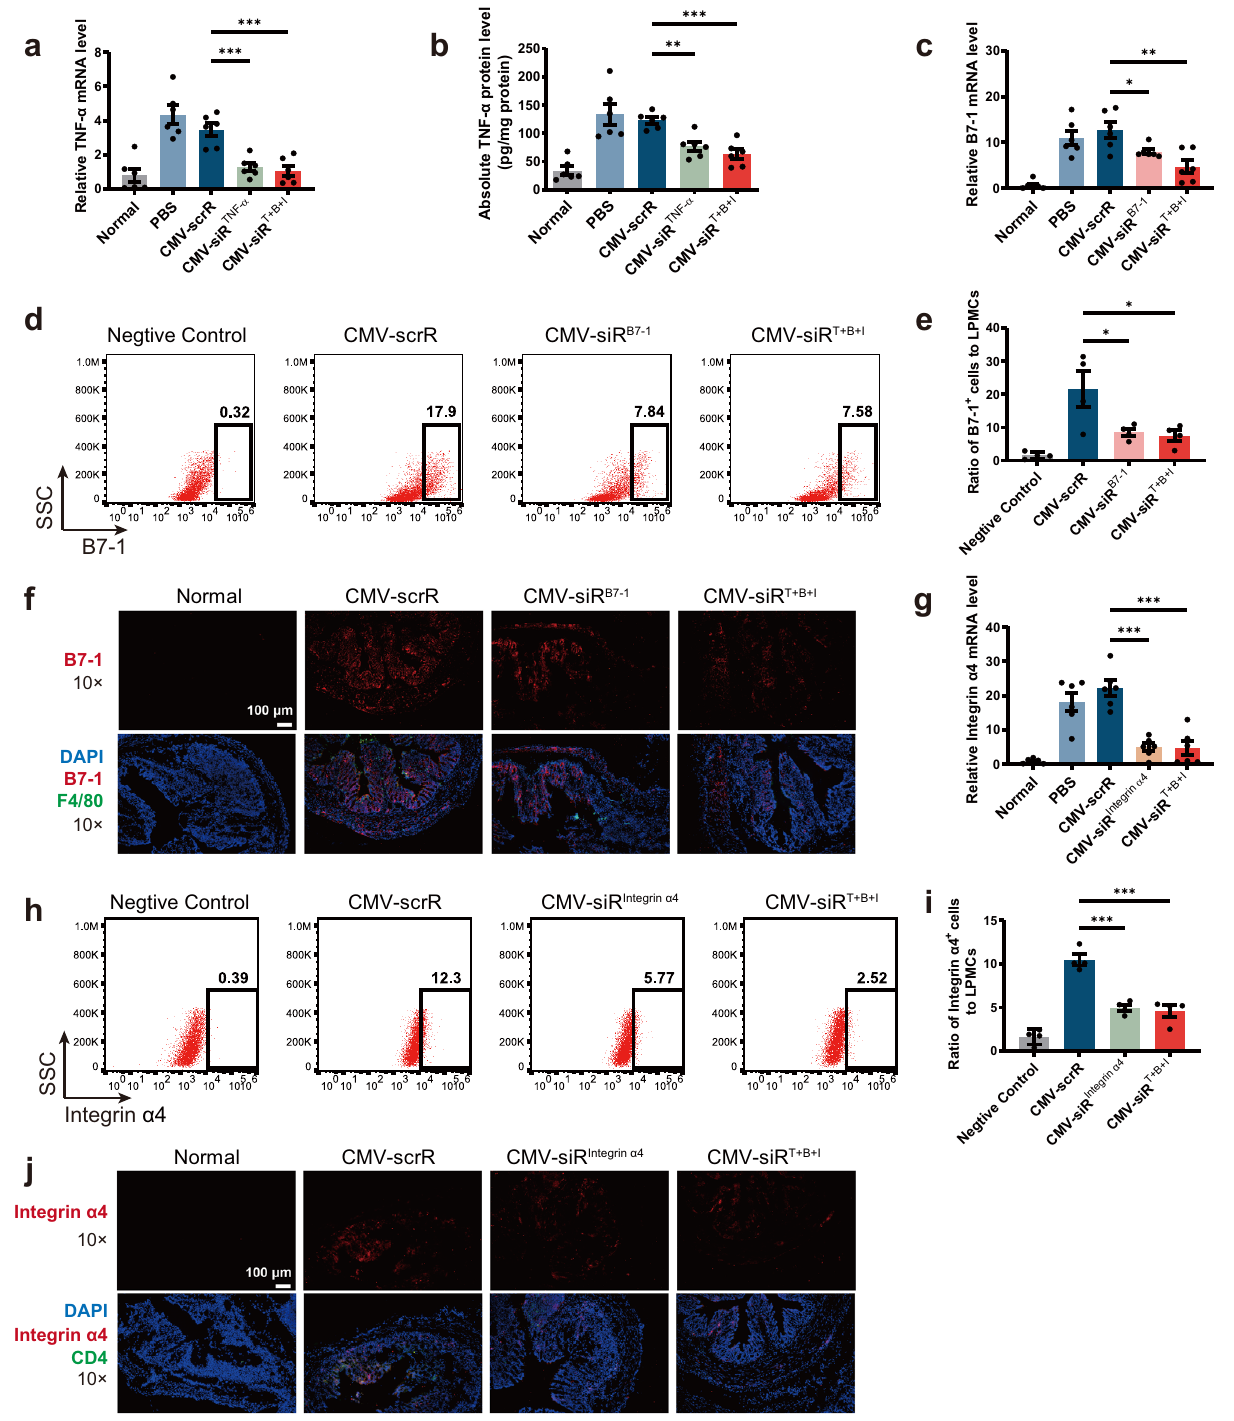
laminapropriamacrophages,wassigni fi cantlydecreasedbytreatment with the CMV-siR TNF- α or CMV-siR T+B+I circuit (Supplementary Fig. 13b and 13c). Second, the levels of B7-1 mRNA weresigni fi cantly reduced in the colon of mice injected with the CMV-siR B7-1 or CMV-siR T+B+I circuit (Fig. 8c). Flow cytometry also revealed that the colonic lamina propria mononuclear cells, peripheral blood mononuclear cells and splenic mononuclear cells isolated from DSS mice treated with the CMV-siR B7-1 or CMV-siR T+B+I circuit exhibited reduced amounts of B7-1 protein (Fig. 8d, e and Supplementary Fig. 14a – d). Immuno fl uorescence staining of B7-1 in primary cultured macrophages of DSS mice